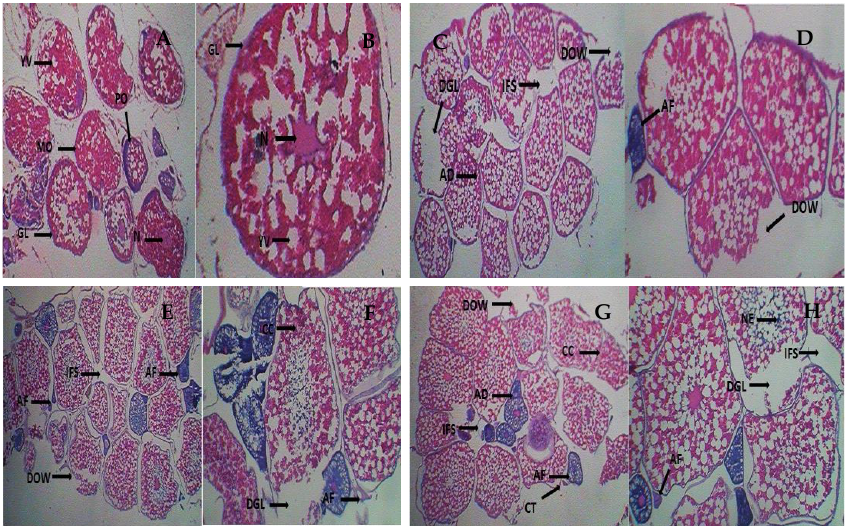
Figure 1. Histological alteration in climbing perch ovaries exposed to different concentrations of ethinylestradiol (EE2)/desogestrel (DES) mixture. ( A – H ) correspond to 0 ng EE2 plus 0 ng DES, 3 ng EE2 plus 15 ng DES, 30 ng EE2 plus 150 ng DES, and 300 ng EE2 plus 1500 ng DES per liter of water fishes were exposed to, respectively; arrows indicate mature oocyte (MO), pre-mature oocyte (PO), nucleus (N), yolk vesicle (YV), granulose layer (GL), degenerated oocyte wall (DOW), wrin- kled oocyte (WO), atretic follicle (AF), degenerated granulose layer (DGL), interfollicular space